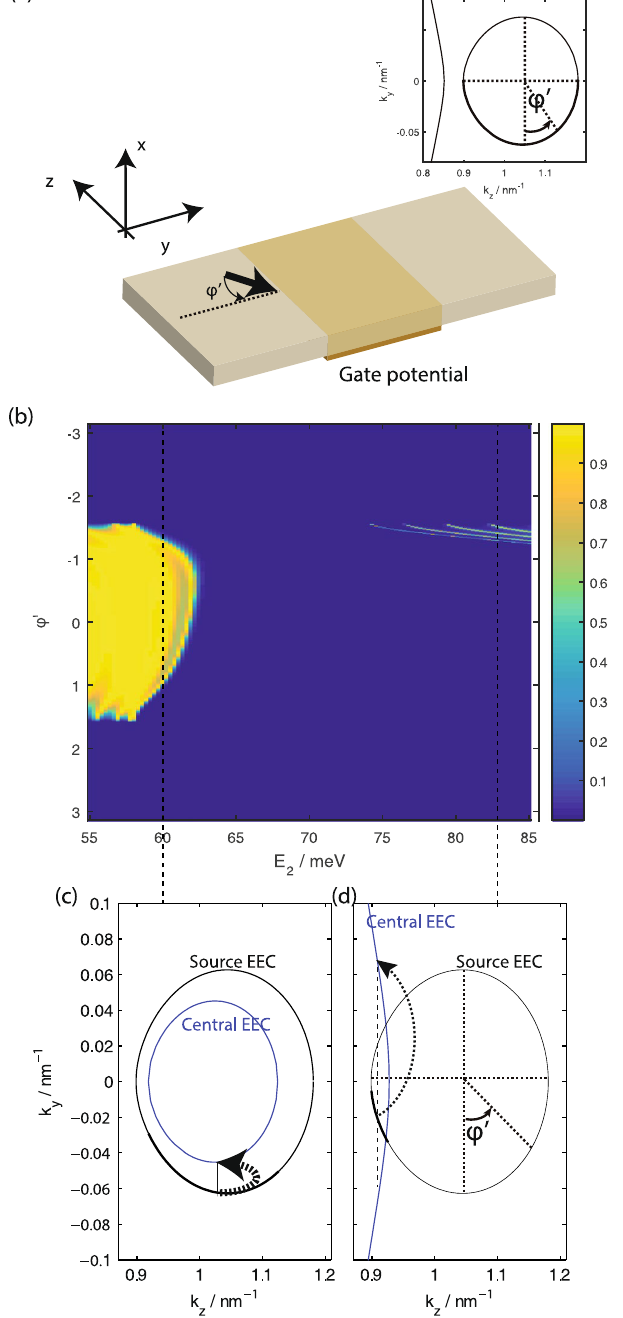
Figure 5. ( a ) The transmission as a function of the source angular coordinate ϕ ′ , and the central segment energy E 2 . ϕ ′ is defined in the inset of the panel where the states propagating in the + y direction are indicated on the thicker line. ( b ) and ( c ) show the source (black) and central segment (blue) EECs at the E 2 values indicated on the plot. The states on the source EEC propagating in the + y direction with ranges of k z that overlap with the k z range of states on the central segment propagating in the + y direction are indicated as thicker lines. The thickness of the arrows pointing from the source to the central segment EECs in ( b ) and ( c ) show the relative probability of transmission form the source states to the central segment states at the value of k z indicated by the dotted